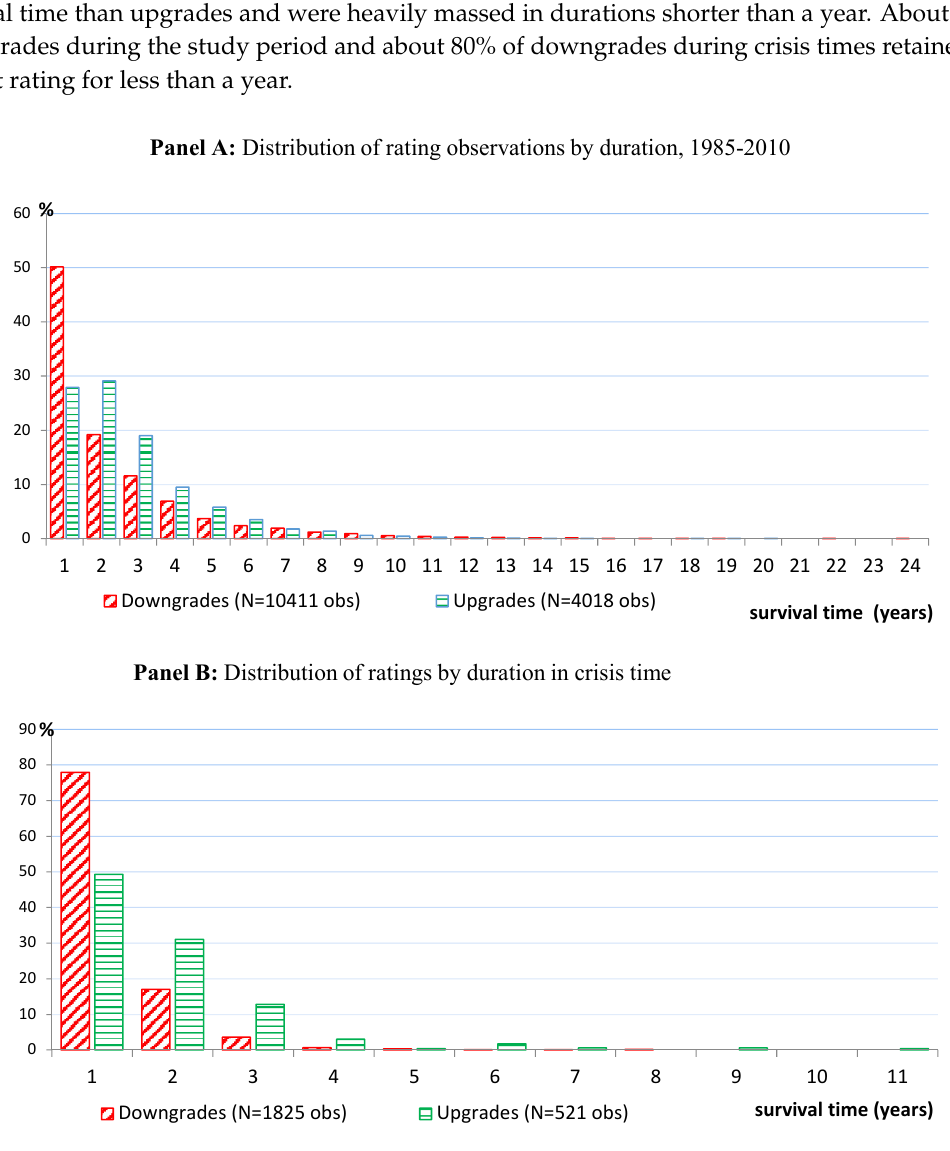
Figure 1. Distribution of rating observations by duration (survival time). Panel A and Panel B of